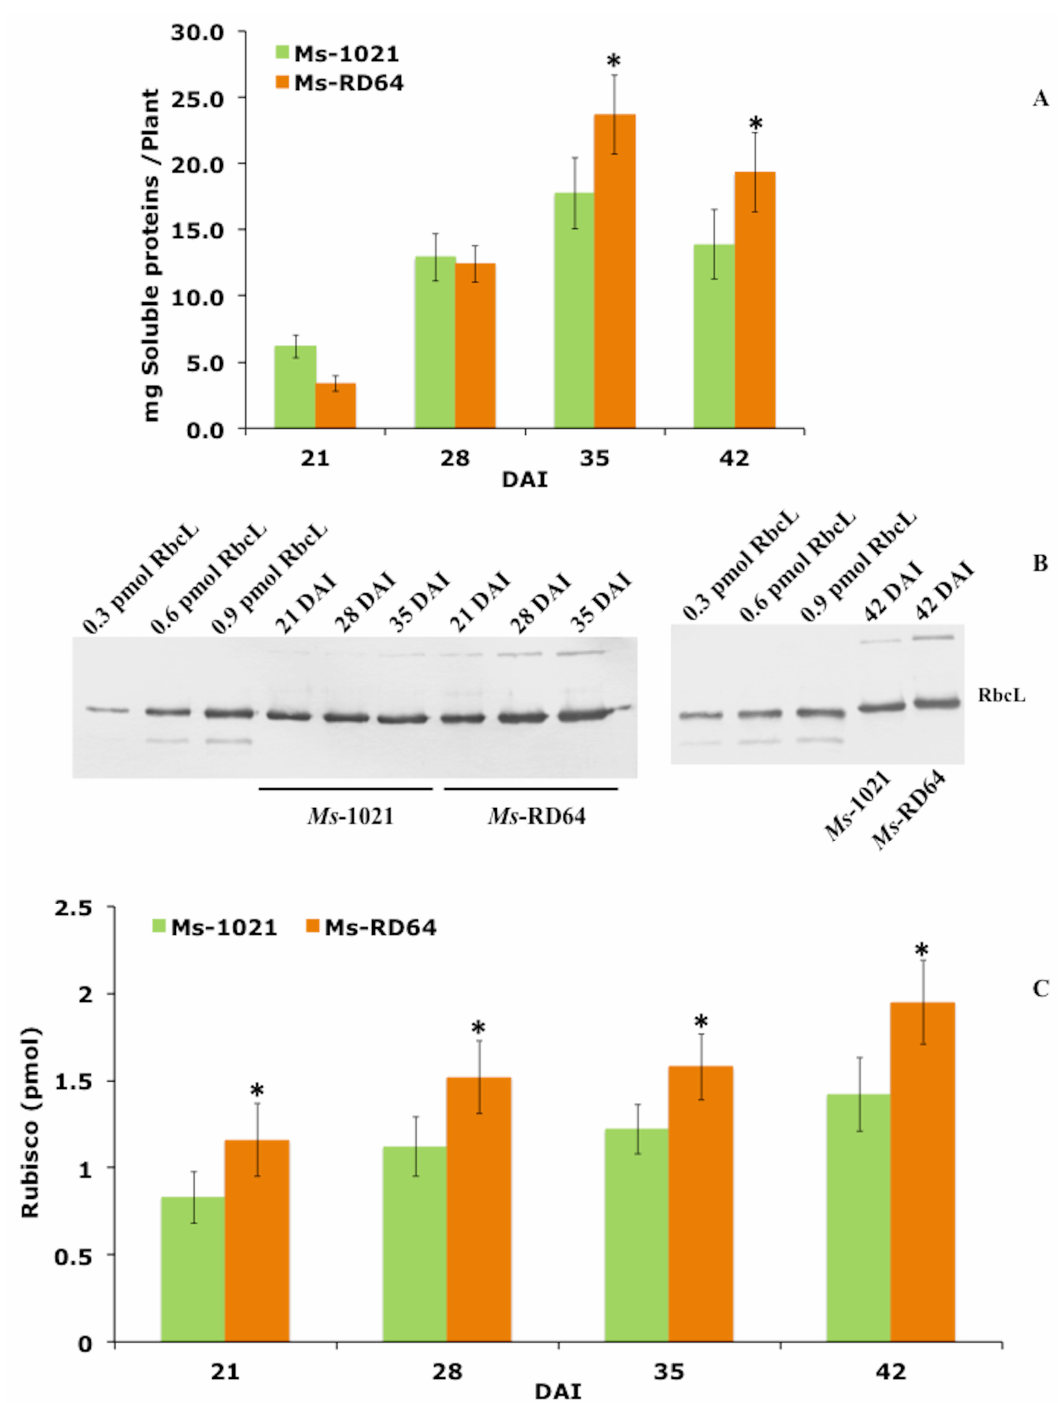
Figure 3. IAA stimulates the biosynthesis of the most abundant plant-soluble protein, Rubisco, in nodulated Medicago plants. ( A ) Soluble protein content in nodulated Medicago plants over time. ( B ) Immunoblot analysis of extracts from M. sativa leaves collected at 28, 21, 35, or 42 days after infection (DAI) subjected to SDS-PAGE, transferred to a nitro-cellulose membrane, and probed with anti-RbcL antibodies (RbcL, Rubisco’s large subunit). ( C ) Immunoblot quantification of the RbcL protein. Data presented are the mean ± SD of four biological replicates. The asterisks in panels A and C indicate significant differences ( P < 0.05, one-way ANOVA with Tukey’s post-hoc test) between 1021- and RD64-nodulated plants.